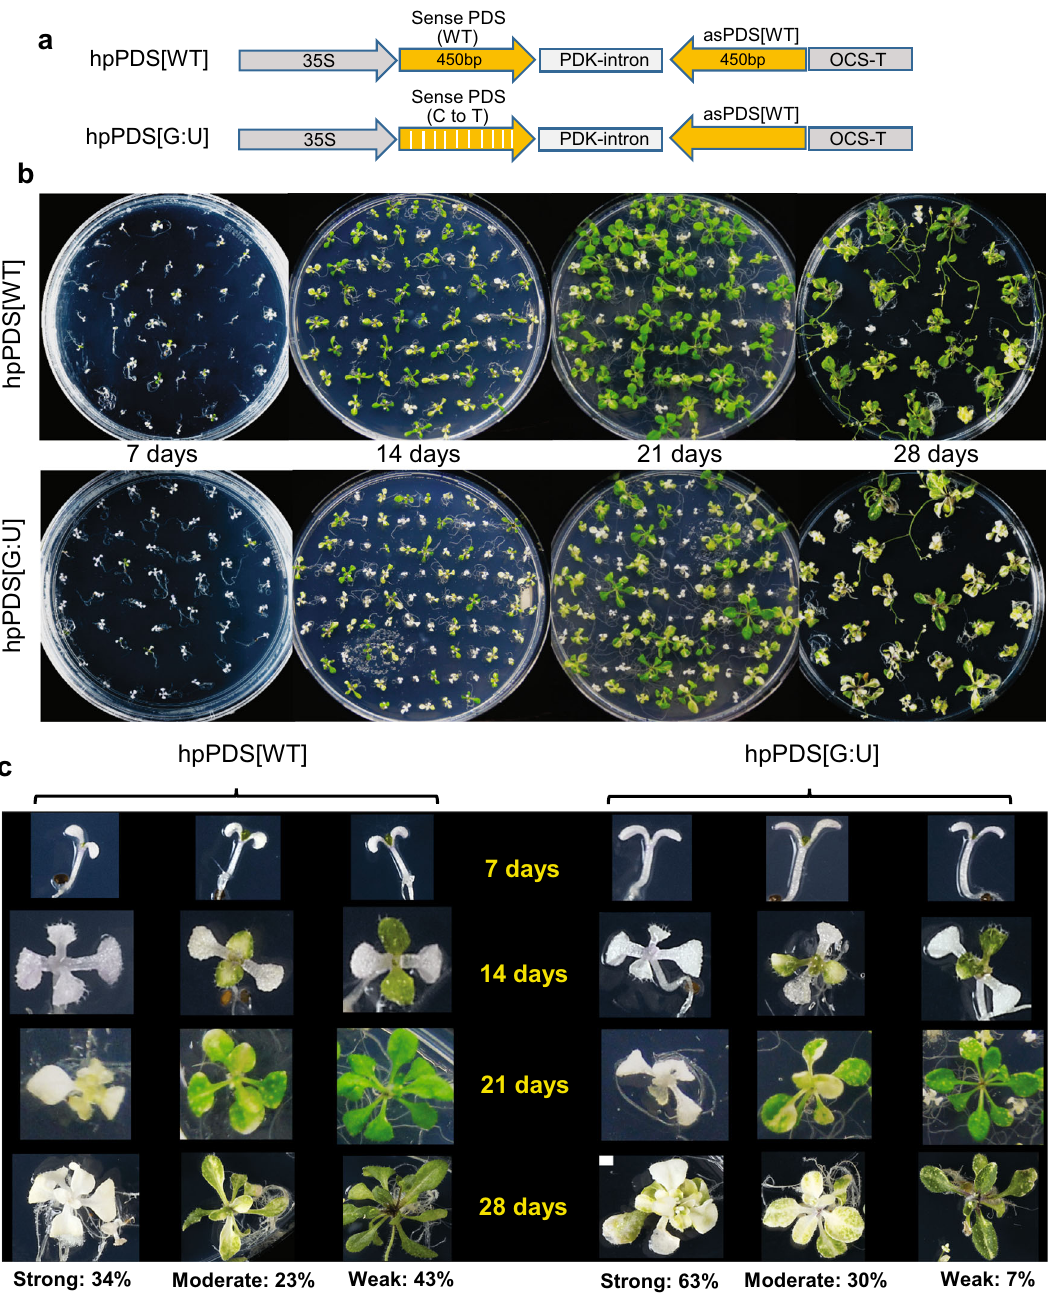
Fig. 3 G:U modi fi ed hpRNA construct induces uniform and persistent RNAi of the endogenous PDS gene in Arabidopsis. a Schematic of the traditional (hpPDS[WT]) and the G:U modi fi ed (hpPDS[G:U]) constructs. b Phenotypes of primary independent transformants with the hpPDS[WT] and hpPDS[G:U] constructs. Note that all lines have photo-bleached cotyledons, indicating strong PDS RNAi in cotyledons, but some lines developed green true leaves indicating loss of PDS silencing in leaves. c Summary of PDS RNAi in the primary transformants, showing a higher frequency of persistent PDS RNAi in the hpPDS[G:U] population. The plants were classi fi ed into three groups based on strong (strong photo-bleaching in the whole plant), moderate (pale green or mottled leaves), and weak (fully green or weakly mottled leaves) PDS G:U hpRNA transgenes show diminished promoter methyla- Seven of the 10 hpGUS[WT] lines analyzed (Fig. 4a) showed a tion . The enhanced uniformity of RNAi by the mismatched clear reduction in PCR band intensity in McrBC-digested vs hpRNA transgenes suggested a reduced level of self-silencing, undigested samples (Fig. 4b), indicative of DNA methylation at which could be due to reduced DNA methylation at the mis- the 35S-GUS junction region. These methylated lines included all matched transgenes compared to the traditional hpRNA trans- the 5 lines (#2, 5, 8, 9, and 10) that showed no or low levels of genes. To investigate this, we analyzed DNA methylation in the GUS RNAi (Fig. 4a). In contrast to hpGUS[WT], all the 10 hpGUS, hpEIN2, and hpPDS transgenes, using methylation- hpGUS[G:U] lines showed equal or near-equal PCR ampli fi cation dependent enzyme McrBC-digestion-PCR and bisul fi te between McrBC-treated and untreated samples (Fig. 4b), indicat- sequencing. ing no or low levels of DNA methylation. To more accurately